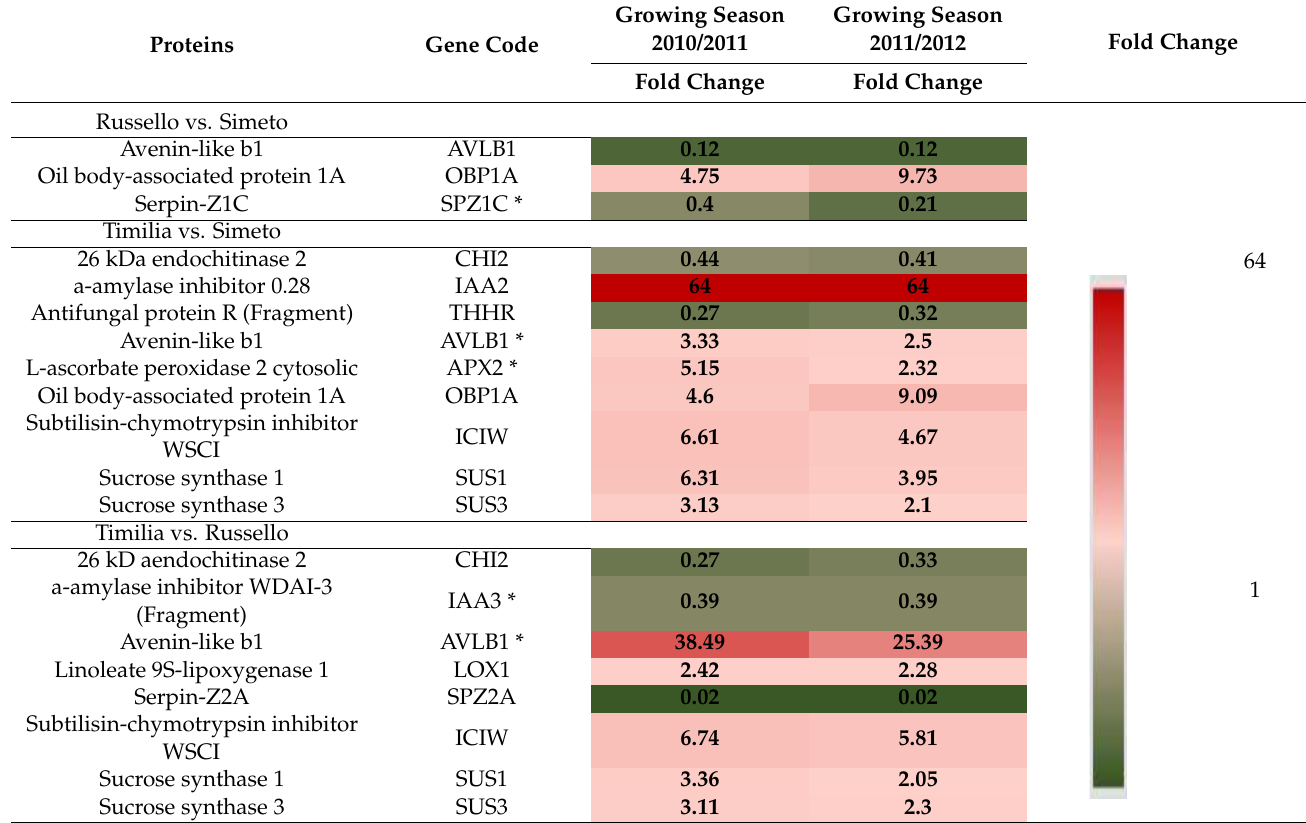
Table 1. Protein profile heat map (cell color represents the fold change observed across the genotype investigated). Each cell also reports the corresponding fold change observed in the two growing seasons. Proteins marked with an asterisk were also detected as intra-genotype DAPs. For details see Table 2.